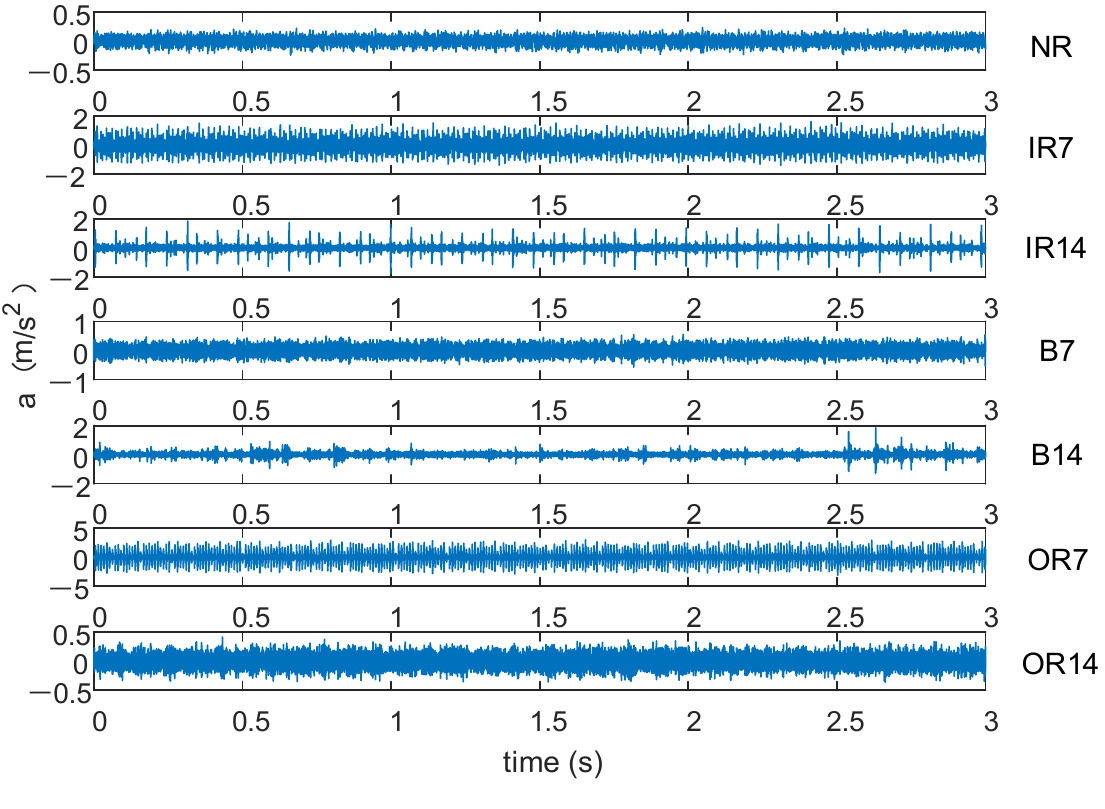
Figure 2. Original vibration signal.